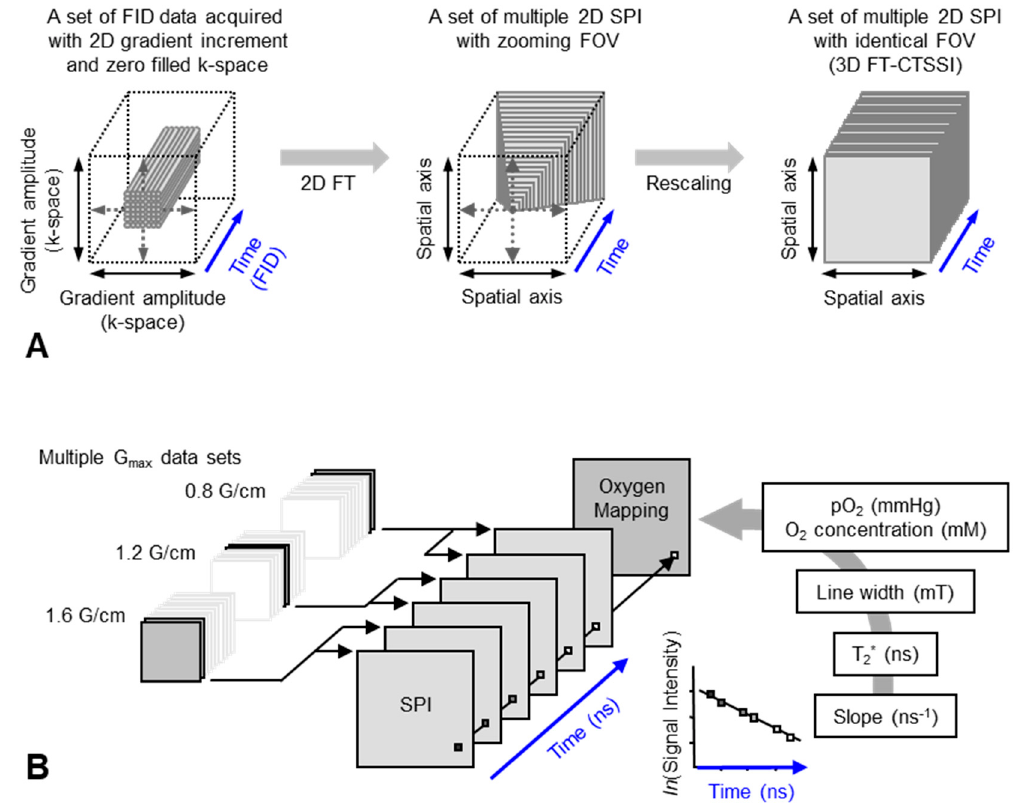
Figure 4. Data handling process for 2D oxygen mapping. ( A ) Data handling process for 2D SPI and 3D FT-CTSSI. Acquired FID were arranged on 3D matrix consisting of 2D k-space and 1D time axis and the k-space was zero-filled to make matrix size as 2 n × 2 n . Then, the 2D k-space at every time point was 2D Fourier transformed. Two-dimensional SPI was computed for every time point, however, the FOV of SPI becomes smaller with increasing delay time. Identical FOVs were extracted and rescaled on 3D FT-CTSSI matrix, which consists of 2D spatial and 1D time axis. (Time axis was Fourier transformed to spectral axis, when required) ( B ) Correction of image resolution by multiple maximum field gradient (G max ) data sets. Multiple CTSSI data sets were acquired with different G max setting. SPI data having similar resolution were extracted from the CTSSI data sets with different G max setting, and then CTSSI data set was re-assembled. T 2 * was calculated from the exponential decay of the image intensity along with time axis. T 2 * values, which are related to EPR linewidth, were converted to corresponding oxygen concentration (or pO 2 ) using previously obtained standard curve.